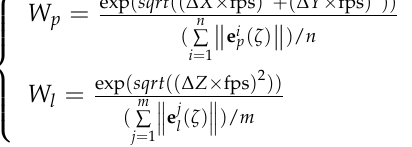
Figure 7. Linear fitting curve between the residual error of the positioning result and the current motion state of a camera. There are 994 motion states and their corresponding residual errors to fit the blue linear curve.